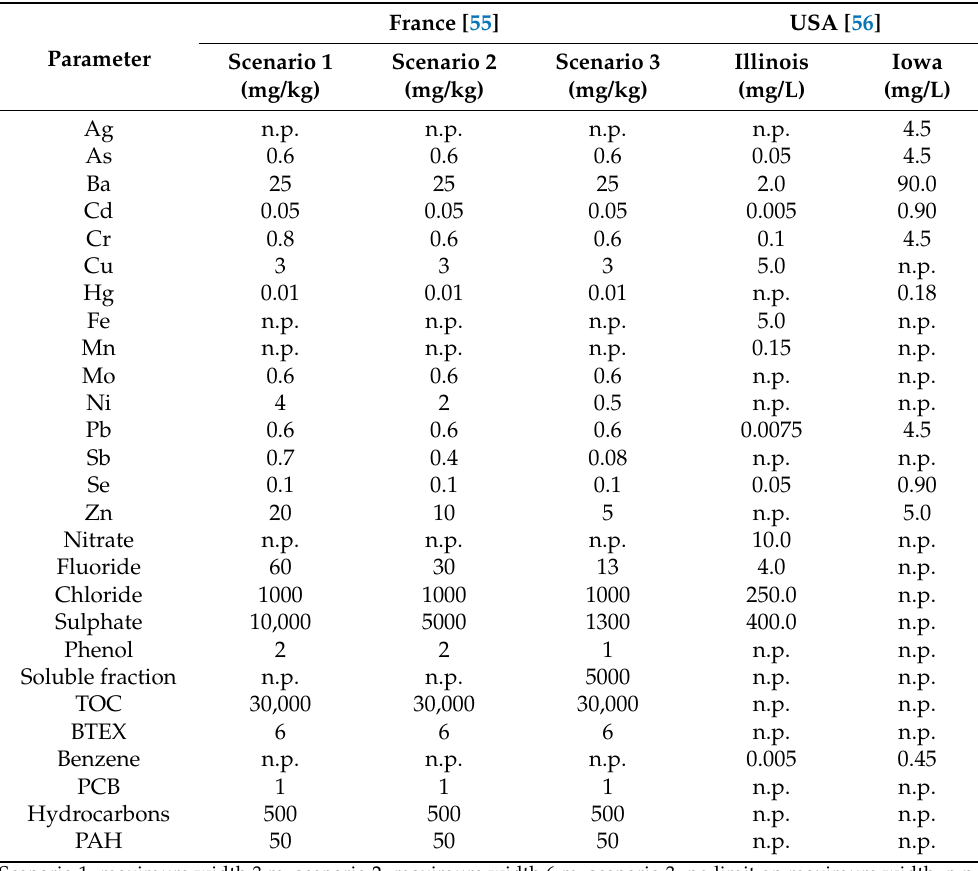
Table 6. Limit values in the leaching test for the use of WFS by French guidelines, and Illinois and Iowa for structural